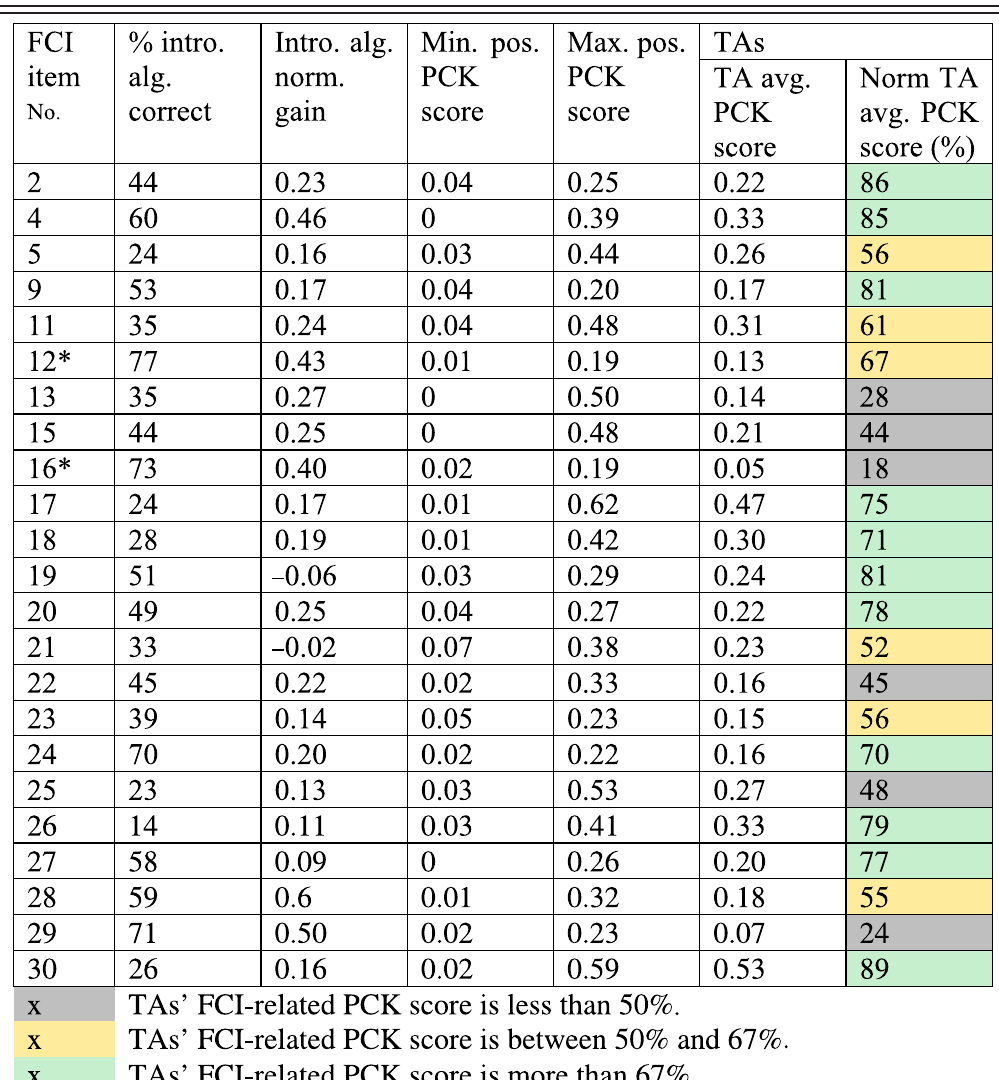
TABLE II. Questions on the FCI on which at least 20% of introductory algebra-based students selected one incorrect answer choice in a post-test (questions 12 and 16 marked with * had 19% of students selecting one answer choice, but they are included here because on these questions many TAs selected incorrect answer choices as most common among introductory students, but very few introductory students selected those answer choices), percentages of introductory algebra-based students who answered each question correctly (% intro. alg. correct), normalized gain (intro. alg. norm. gain), minimum possible FCI-related PCK score (min. pos. PCK